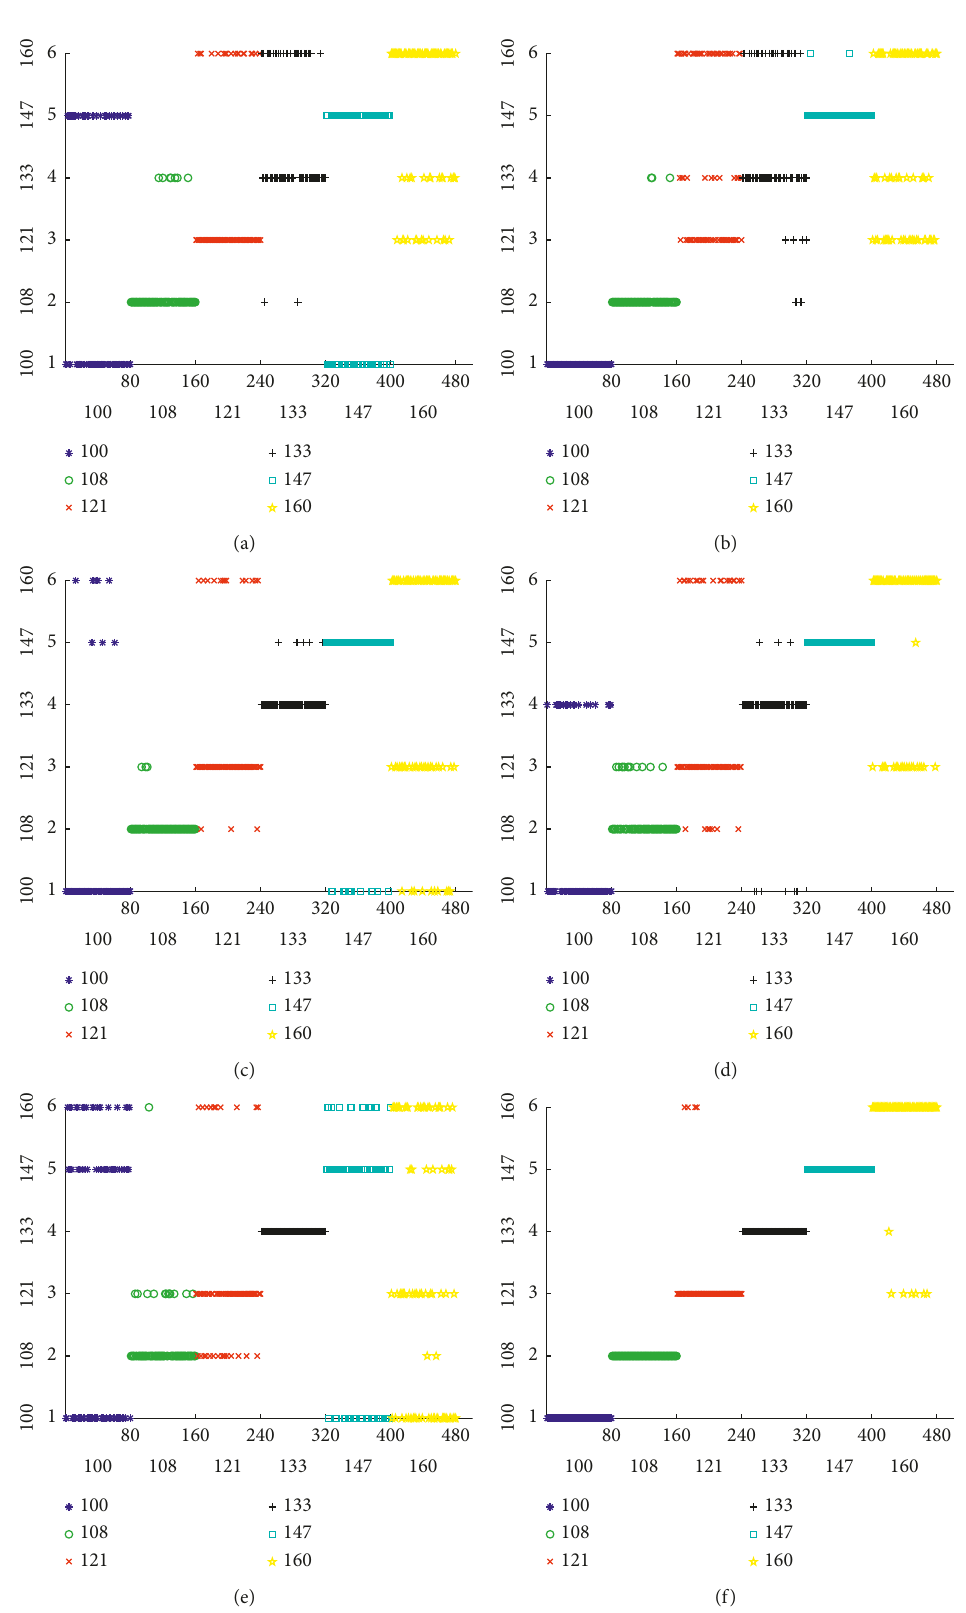
Figure 5: Feature classification and recognition distribution. (a) PE, (b) WPE, (c) DE, (d) FDE, (e) RDE, (f)